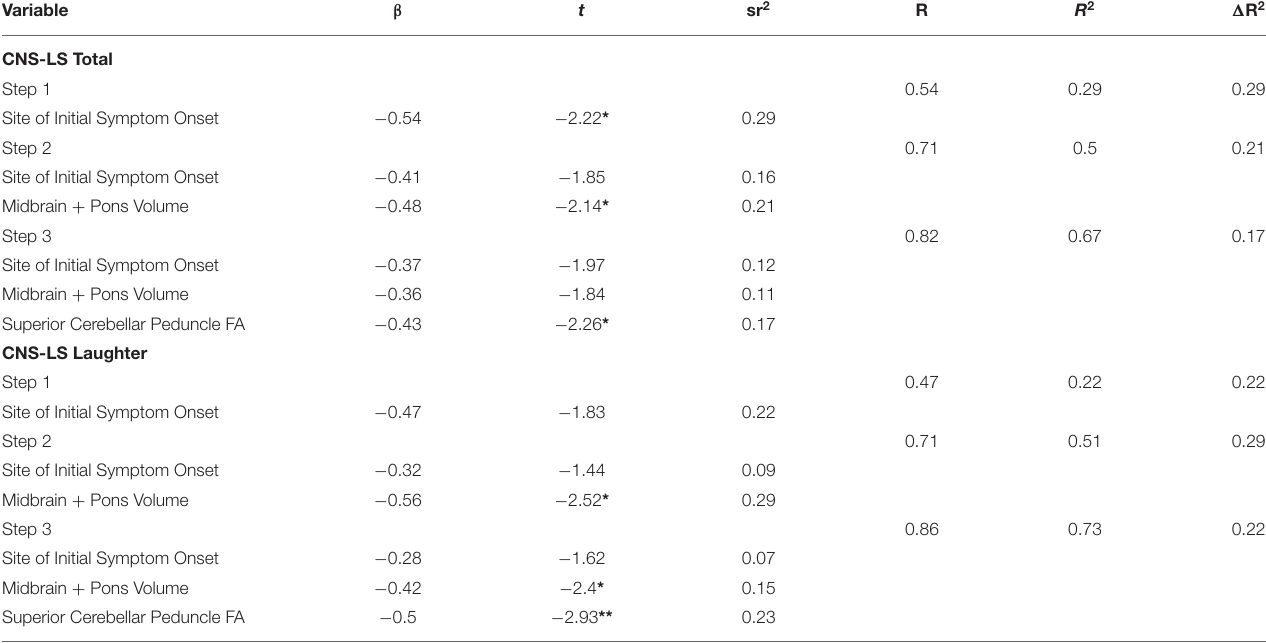
TABLE 2 | Hierarchical regression analysis for brainstem MRI variables predicting CNS-LS total and laughter